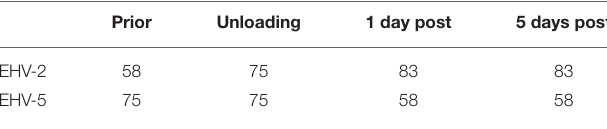
TABLE 1 | Detection of gammaherpesviruses by qPCR in nasal swabs expressed as a percentage of study population ( n = 12) at various time points in the transportation